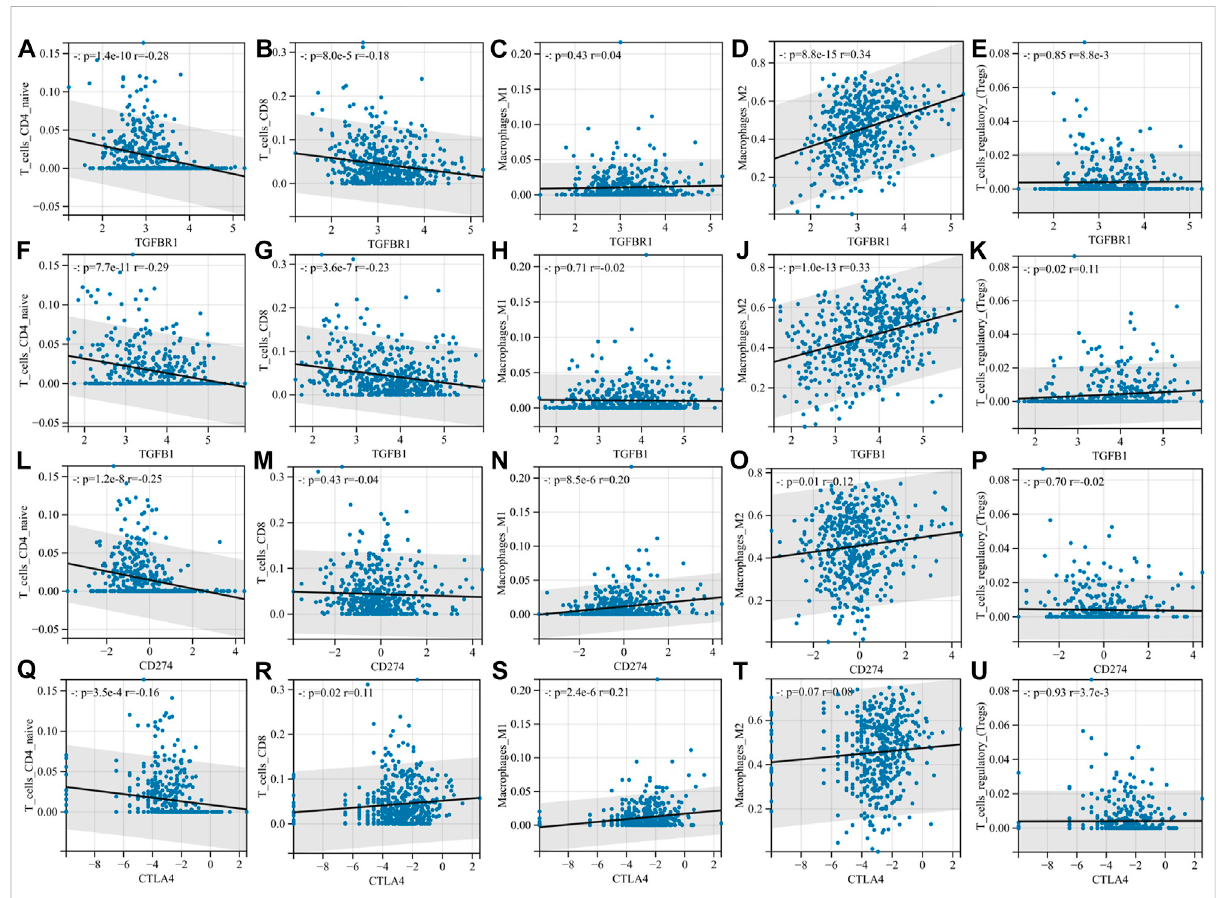
FIGURE 7 Compared with PD-L1 and CTLA-4, TGFB1/TGFBR1 is more associated with the immunosuppressive microenvironment. (A – E) Correlation of TGFBR1 with immune cell in fi ltration; (F – K) correlation of TGFB1 with immune cell in fi ltration; (L – P) correlation of PD-L1 with immune cell in fi ltration; and (Q – U) correlation of CTLA-4 with immune cell in fi